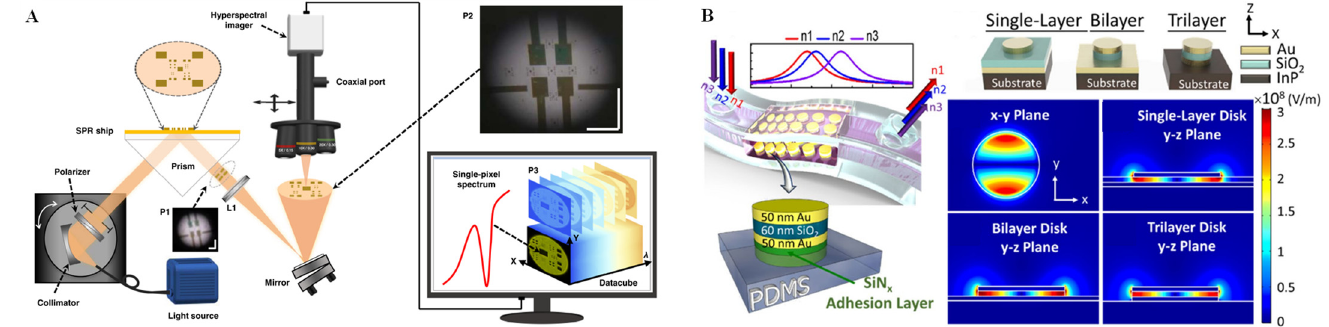
Figure 3. SPR technique and applications. ( A ) Schematic diagram of the HSPRM system. Reprinted with permission from ref. [54], Copyright 2022, Nature communications. ( B ) Schematic of the MIM-disk LSPR refractive index sensor embedded in a flexible PDMS chip and the electric field mode profile with a different plane of this sensor. Reprinted with permission from ref. [56], Copyright 2018 Springer Nature.